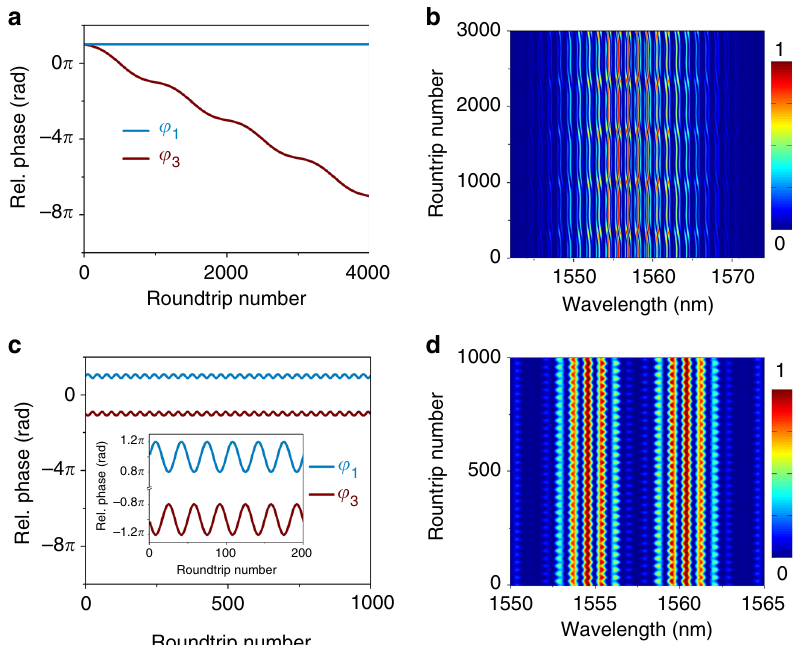
Fig. 4 Analytical fi ts for the dynamics of soliton molecular complexes. a Evolution of the relative phases φ 1 and φ 3 , de fi ned in Fig. 1b, as a function of the roundtrip number for the sliding phase dynamics and b the corresponding evolution of the spectral intensity pro fi le. c Phase evolution of φ 1 and φ 3 as a function of the roundtrip number for the oscillating phase dynamics and d the corresponding evolution of the spectral intensity pro fi le. The spectral intensity is represented in colour scale in b and